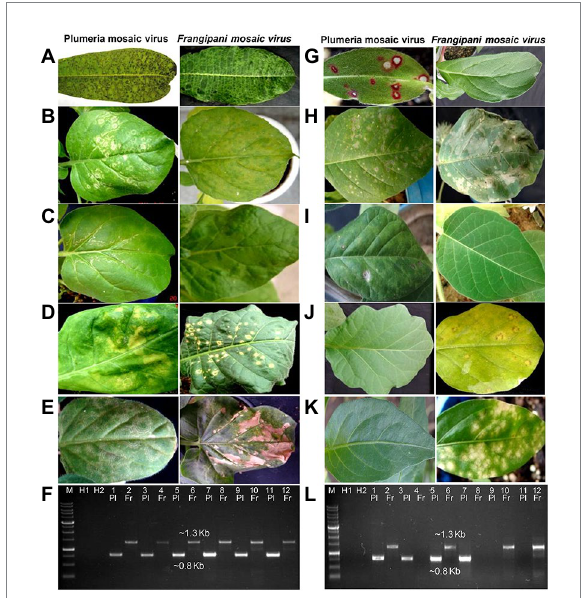
final volume was adjusted to 20.0 μ l with nuclease free water. The reaction mixture was allowed for 90 min at 42 ° C followed by inactivated at 70 ° C for 15 min in the Biometra T Personal thermal cycler. The cDNA (2.0 μ l) was used for PCR with 10x Ex Taq buffer final reaction mixture was adjusted to a volume of 50 μ l with the nuclease-free water. The amplification conditions were: 40 cycles, each having denaturation at 98 ° C for 10 s, annealing at 58–62 ° C (Table 2) for 45 s, and extension at 72 ° C for 1.0 min/kb. The final extension was allowed at 72 ° C for 10 min. The amplified products were resolved in agarose gel, purified using gel purification kit (Macherey-Nagel, Germany), and cloned in pT&A vector (Real